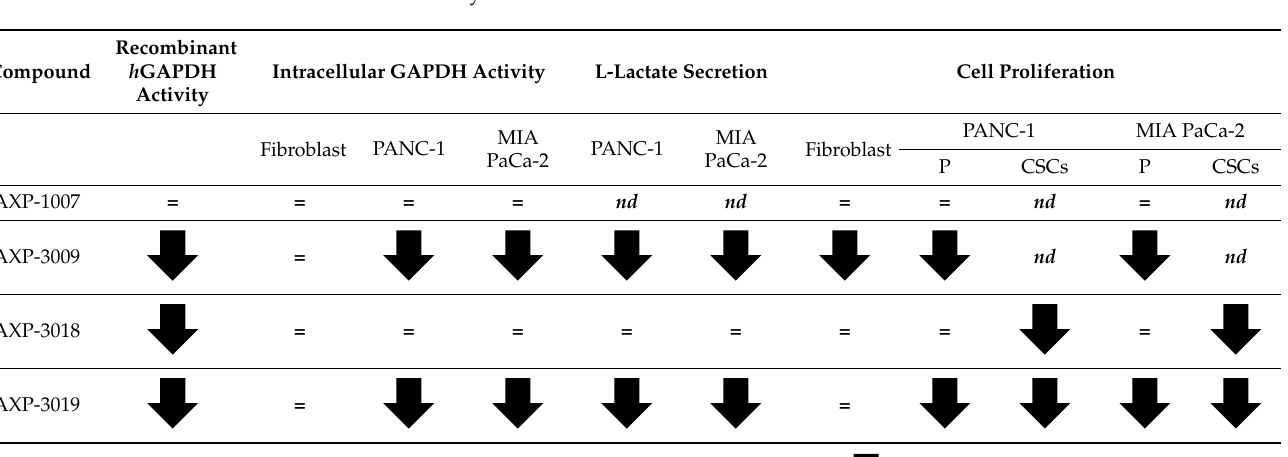
“P”, parental cells; “CSCs”, cancer stem cells; “ nd ”, not done;